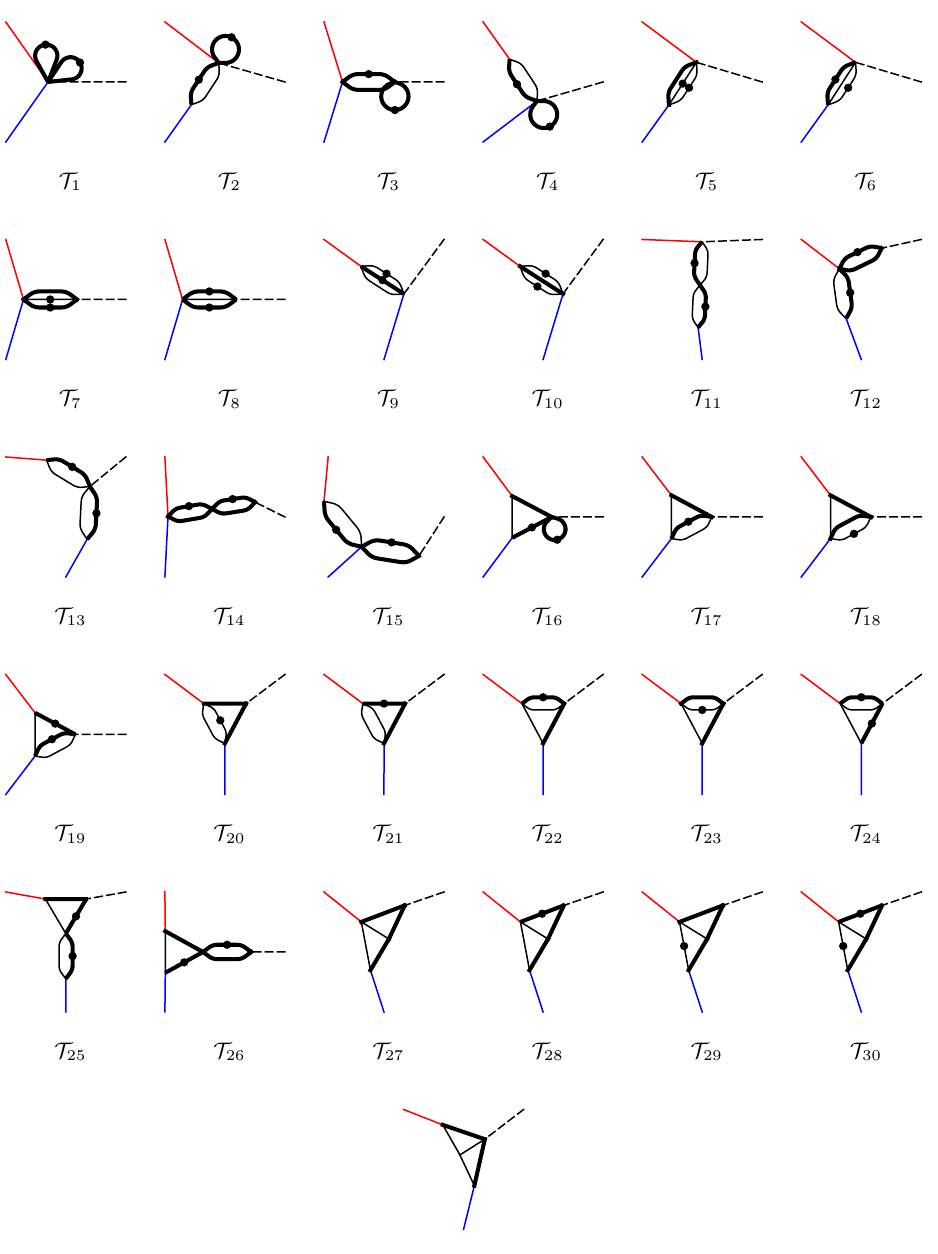
Figure 4. Two-loop MIs T for the topologies (c)-(d). Graphical conventions are the same as 1 ;:::; 31 in (cid:12)gure 2. Dots indicate squared